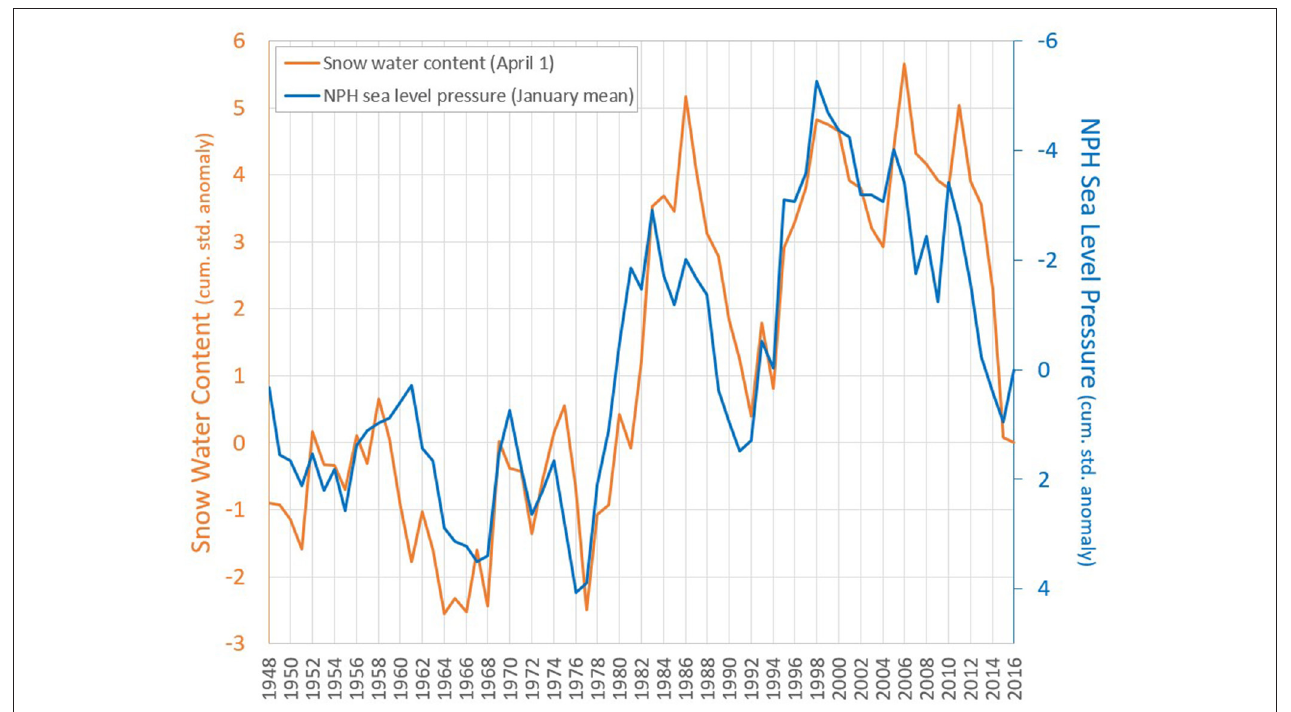
FIGURE 1 | Cumulative standardized anomaly of April 1 snow water content at Mammoth Pass (orange) and January mean sea level pressure at the North Pacific High region [NCEP/NCAR grid cell centered at (35 ◦ N, 232.5 ◦ E)] (blue). The blue line refers to the vertical axis on the right, where values are in reverse order to aid comparison between the two variables, given that they are inversely